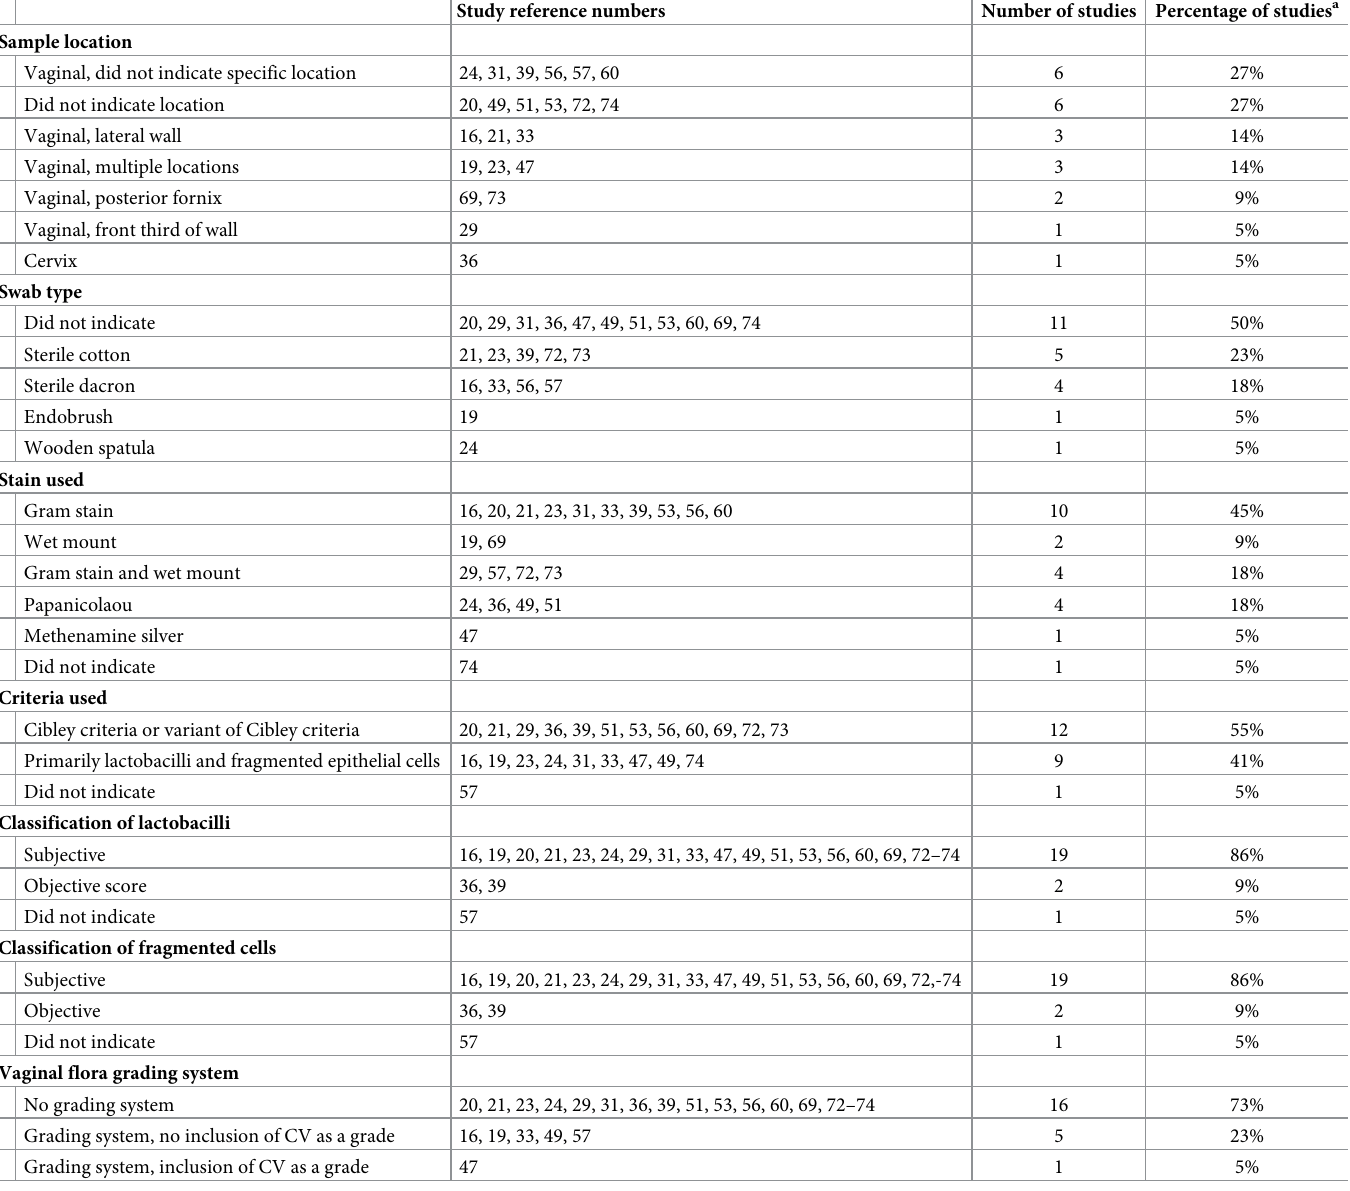
Table 3. Summary of diagnosis variables (n = 22